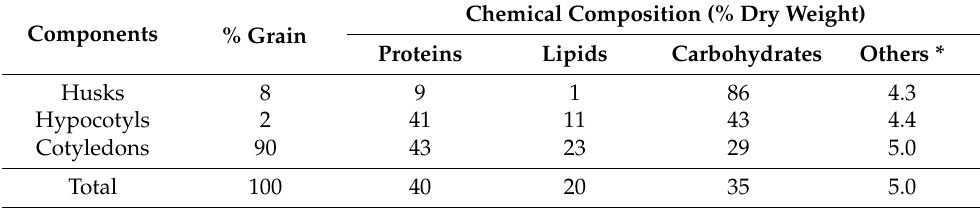
Table 2. Nutritional composition of soybean. Components %